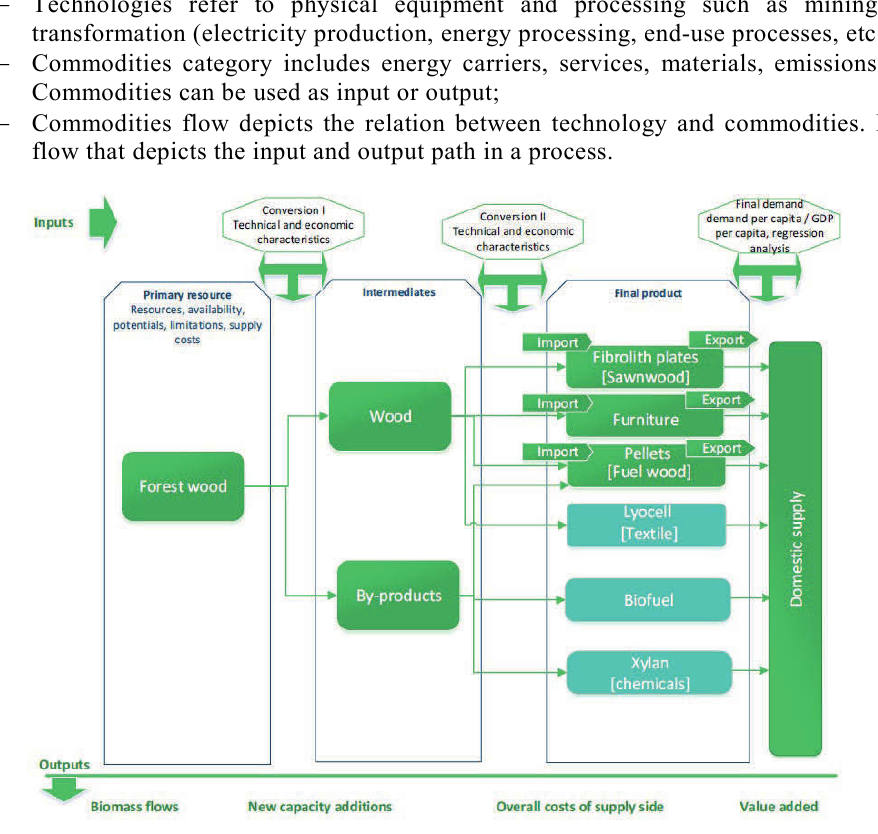
Fig. 2. Forestry bioresource value model